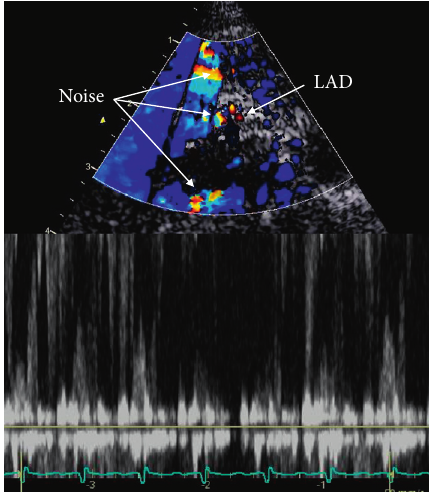
Figure 4: Example of noise artifact compromising coronary flow signal, making coronary flow velocity curves blurred and poorly reproducible. Noise artifacts can occur from surrounding struc- tures (e.g., vessels, epicardial fat, and flow in the left ventricular cavity) and can sometimes mimic coronary flow as they usually increase during